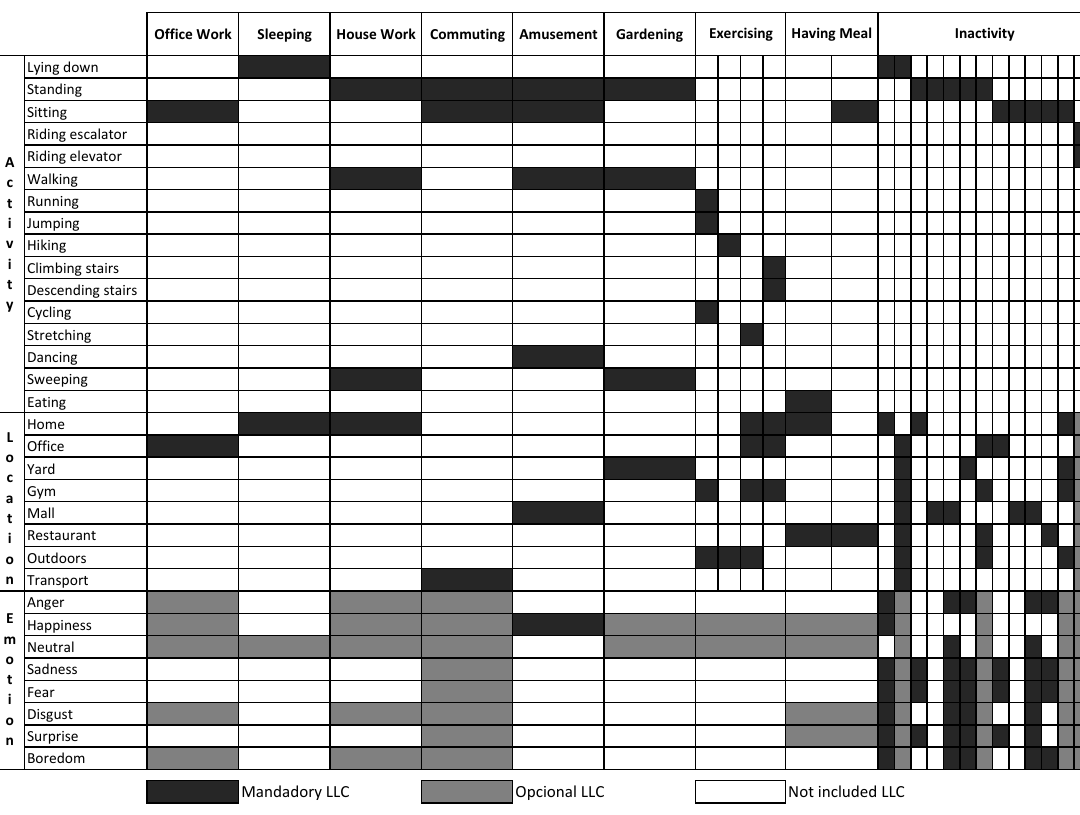
Figure 1. Graphical representation of the combination of low-level contexts that compose the high-level contexts modeled in the Mining Minds Context